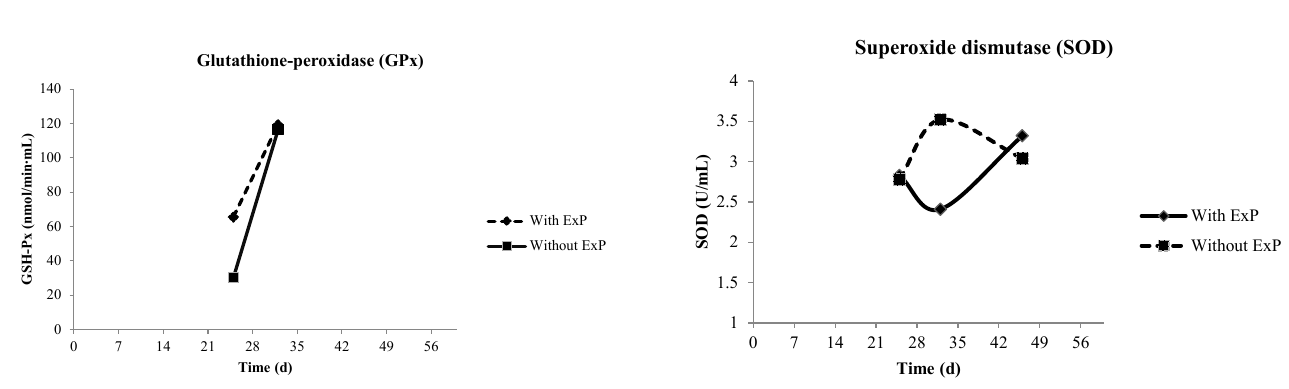
Table 5. Oxidative stress parameters in the plasma of lambs receiving a high-concentrate diet with different antioxidant additives